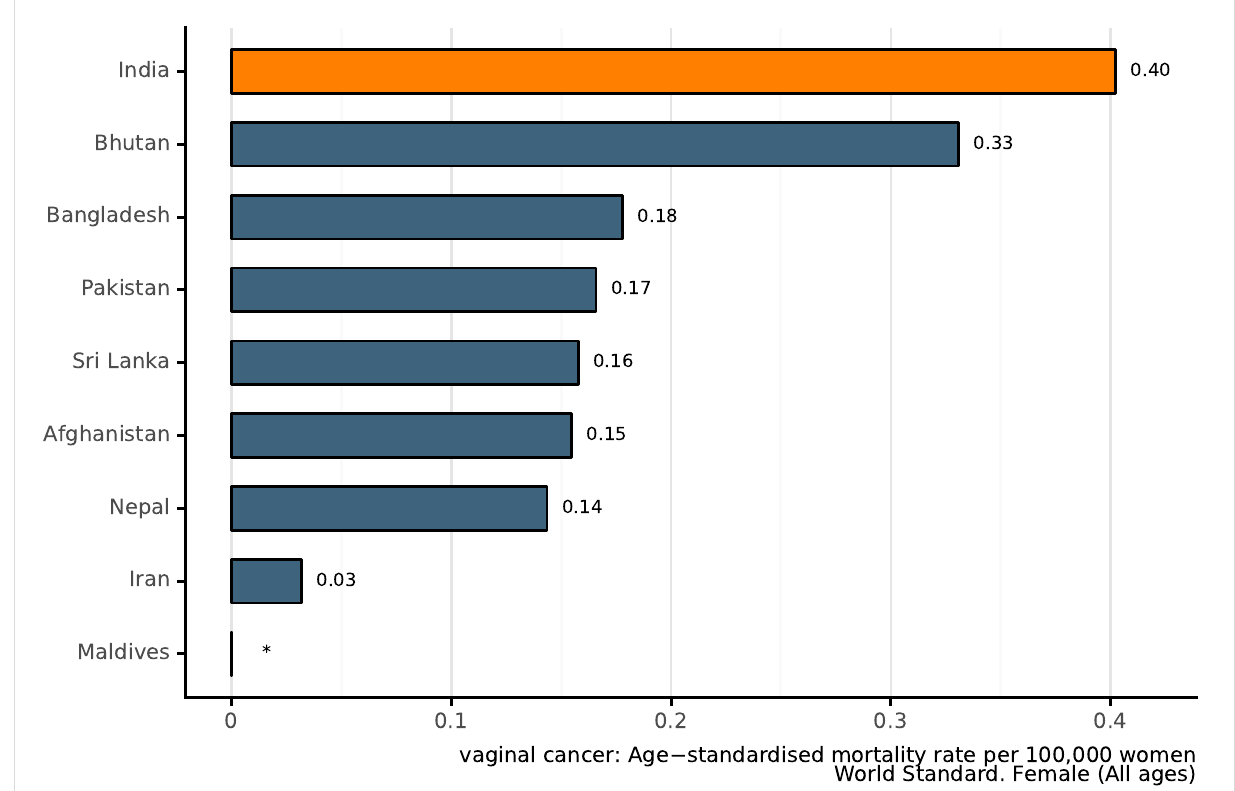
vaginal cancer: Age standardised mortality rate per 100,000 women World Standard. Female